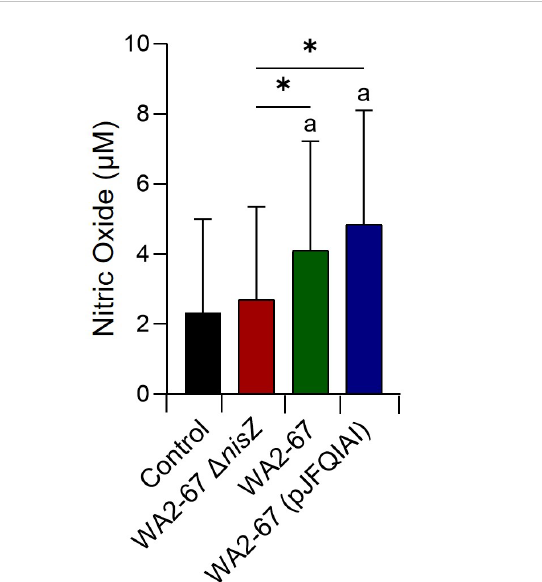
FIGURE 7 Capacity of L. cremoris WA2-67 D nisZ , L. cremoris WA2-67 and L. cremoris WA2-67 (pJFQIAI) to induce nitric oxide (NO) production in splenocytes. Cells were incubated at 20°C for 48 h with the different bacterial strains at a concentration of 1 x 10 4 cfu/ml or with media alone. Subsequently, the optical density (OD) was measured at 540 nm and data readjusted to represent the production of NO in m M. Data are shown as mean values + SD (n = 9). The letter (a) represents NO levels signi fi cantly different than those observed in cells not exposed to bacterial strains (control), while asterisks indicate levels signi fi cantly different between bacterial treatments as indicated (* p ≤